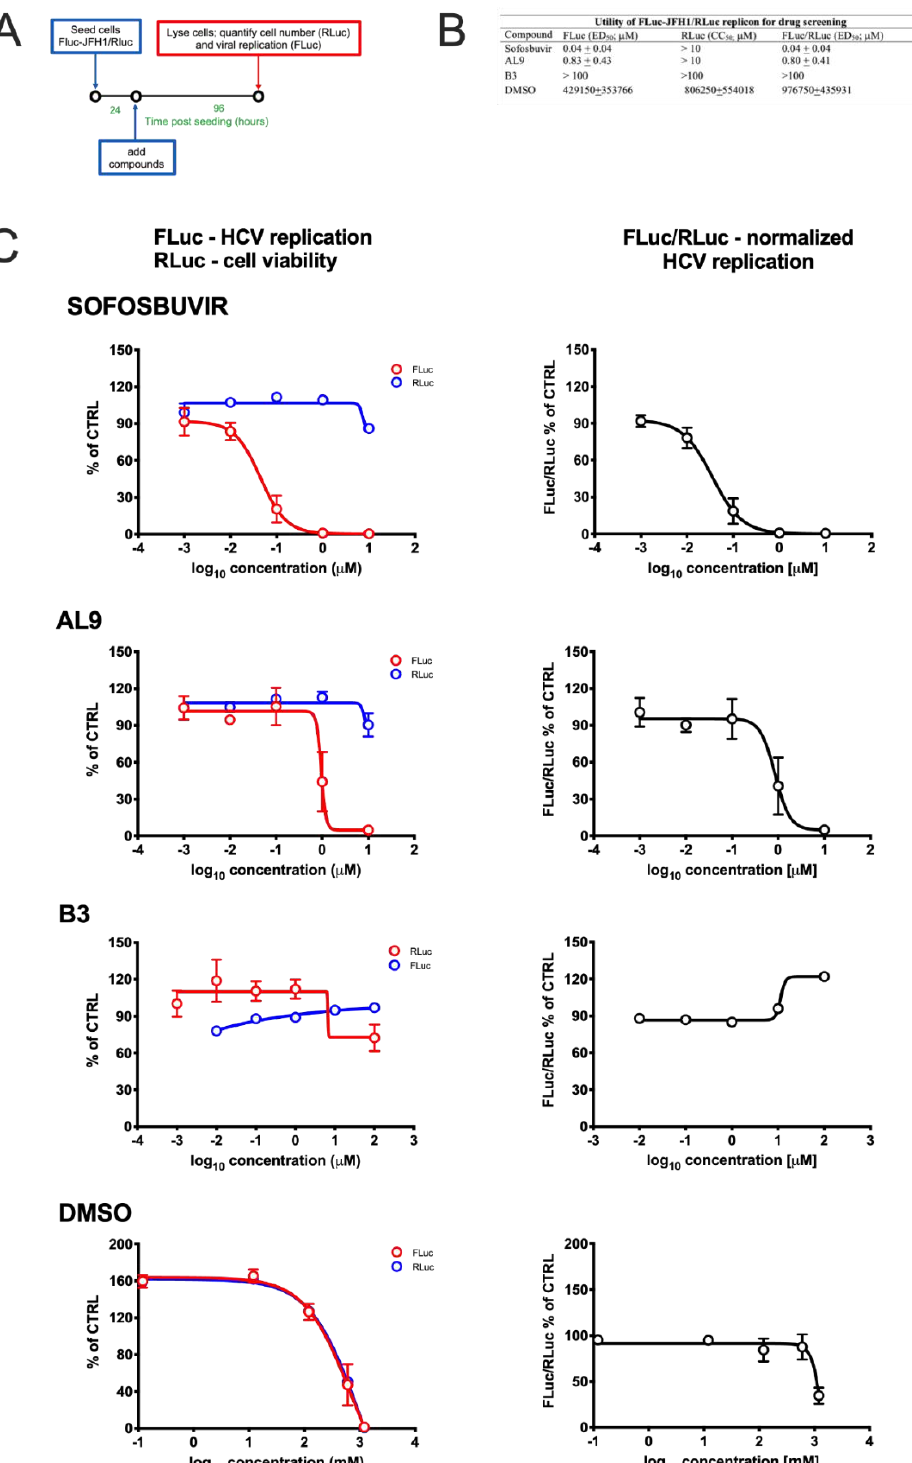
Figure 4. Effect of different compounds on HCV replication and cell viability. ( A ) FLuc-JFH1 / RLuc cells were seeded in 24-well plates (2.5 × 10 4 cells / cm 2 ); 24 h later, cells were treated with increasing concentrations of the indicated compounds; 72 h post-treatment, cells were lysed and processed for luciferase assays for the quantification of viral RNA replication (FLuc) and cell number / viability (RLuc), as described in the Materials and Methods section. ( B ) Curves such as those shown in ( C ) were analysed as described in the Materials and Methods section in order to calculate the effective dose 50 (ED 50 ; FLuc), cell culture 50 (CC 50 ; RLuc) and normalized ED 50 (FLuc/RLuc), relative to the indicated compounds. Data shown are the mean + standard deviation of the mean relative to the